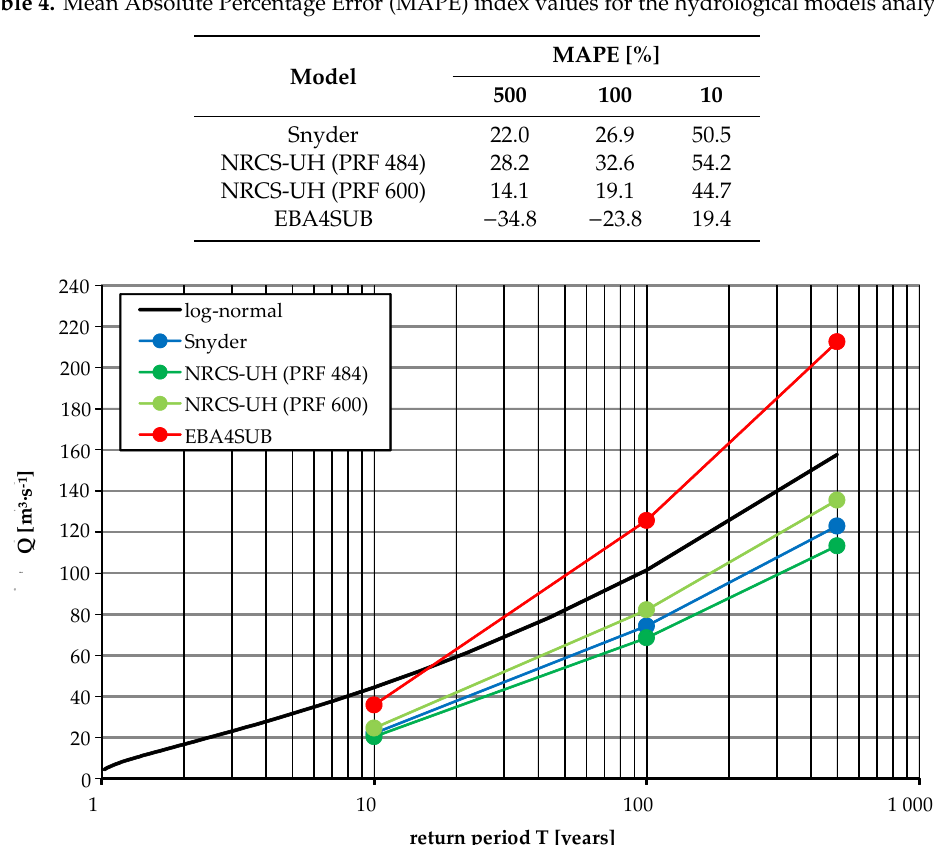
Figure 8. Q T values obtained with the analysed hydrological models against the background of log-normal distribution.